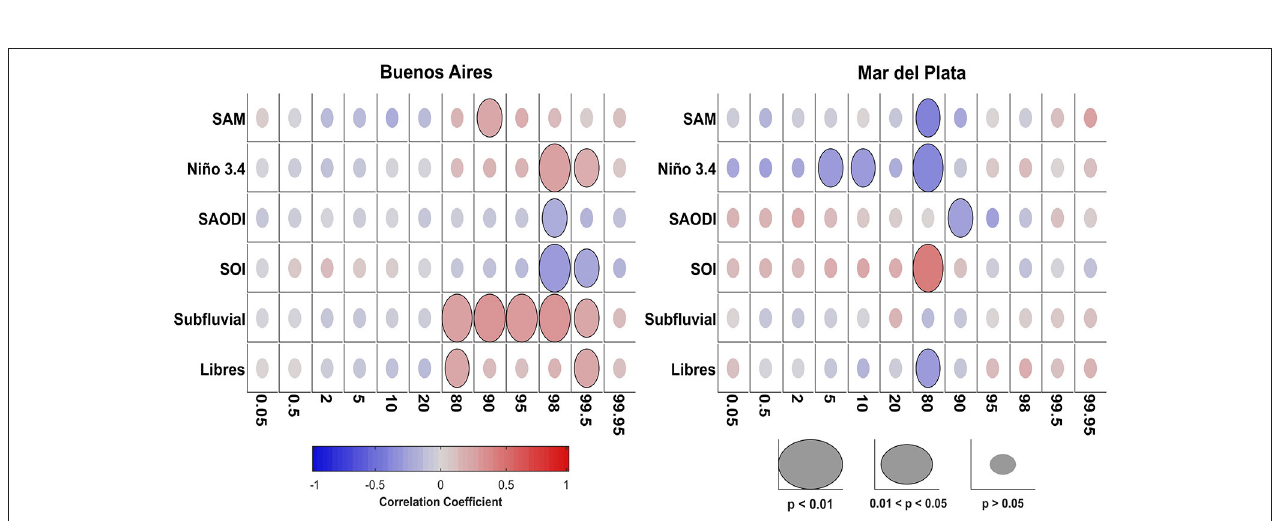
FIGURE 3 | Correlation between climate indices, river runoff and the reduced (to median and tide) annual percentiles of Buenos Aires and Mar del Plata.